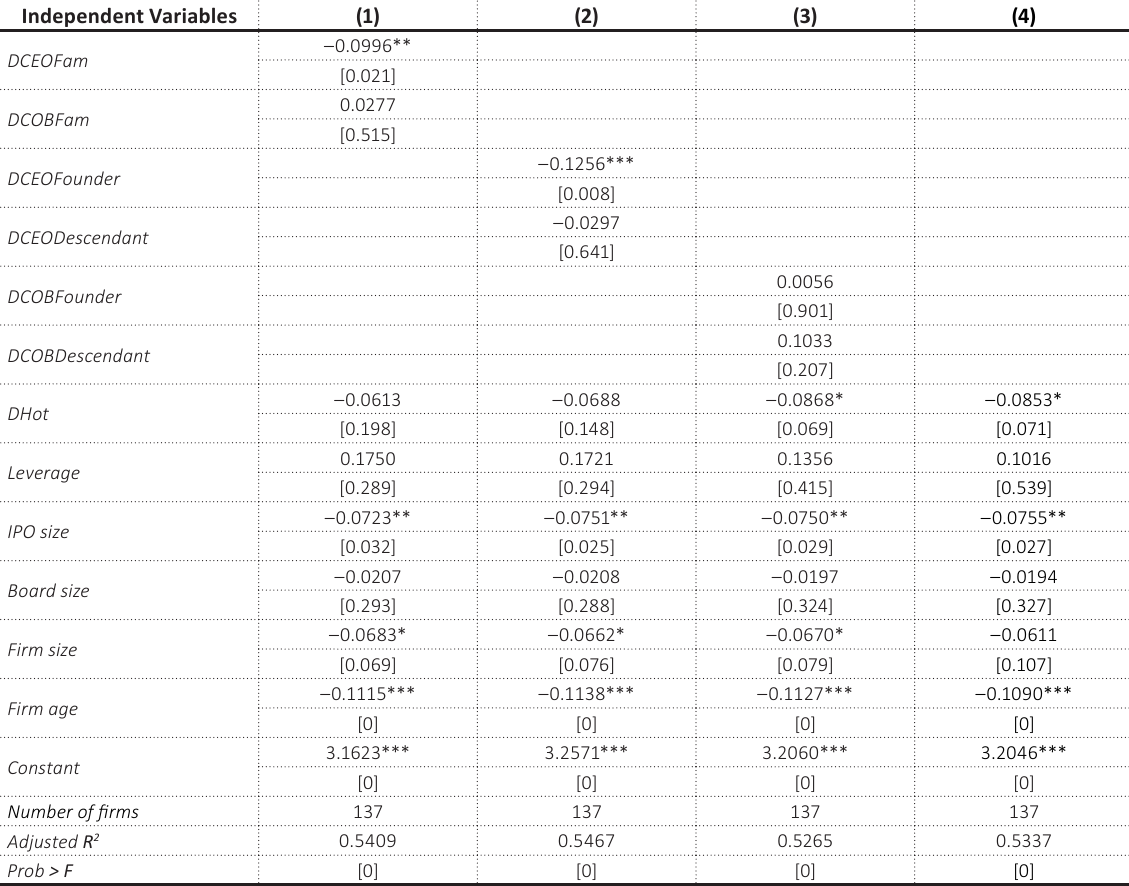
Table 5. Effect of family involvement and family generations on IPO